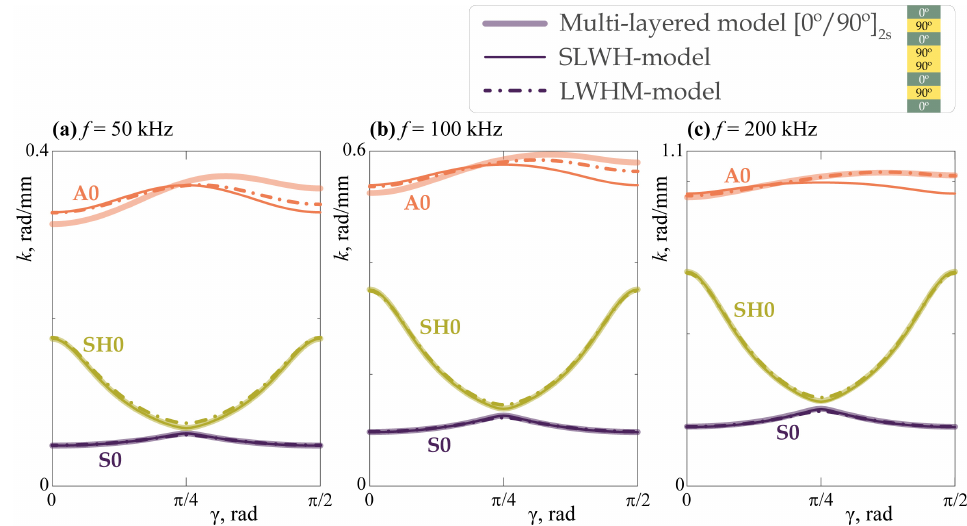
Figure 2. Wavenumbers k n ( γ ) for [ 0 ◦ ,90 ◦ ] 2s : multi-layered waveguide (thick solid lines), homoge- nized waveguides (thin solid and dashed lines for Models 1 and 2, respectively).